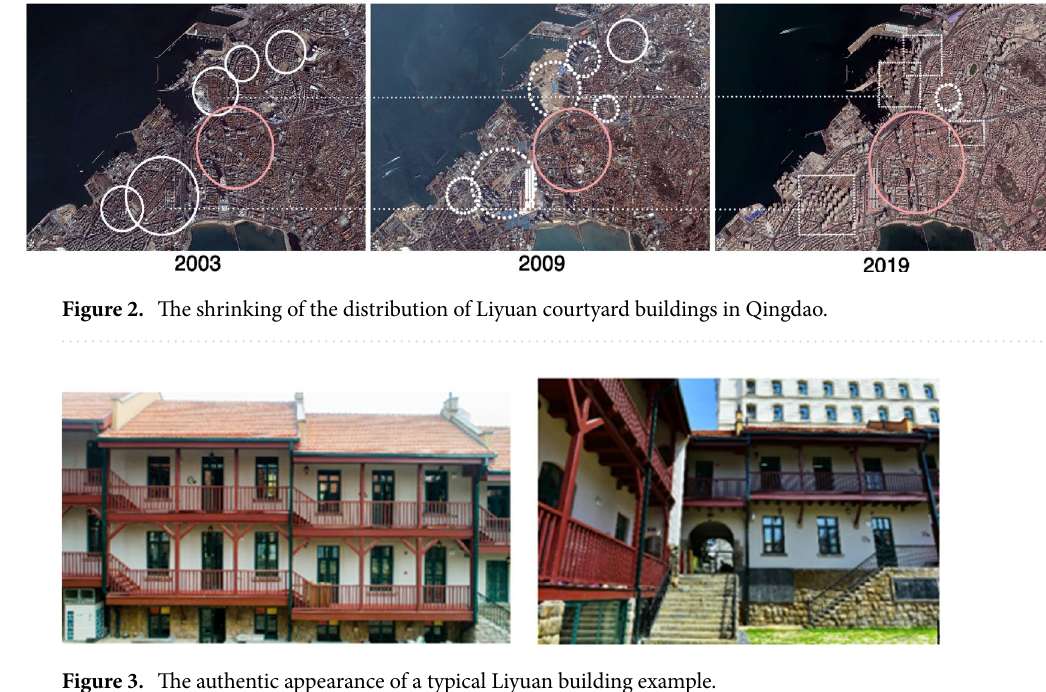
Figure 3. The authentic appearance of a typical Liyuan building